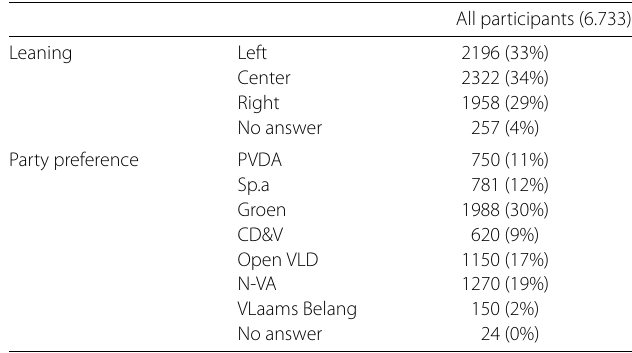
Table 4 The number of participants in our dataset per target variable All participants (6.733) Leaning Left 2196 (33%) Center